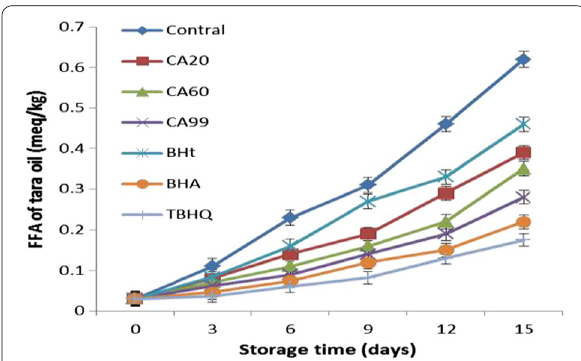
Fig. 5 FFA results for tara seed oil samples after accelerated